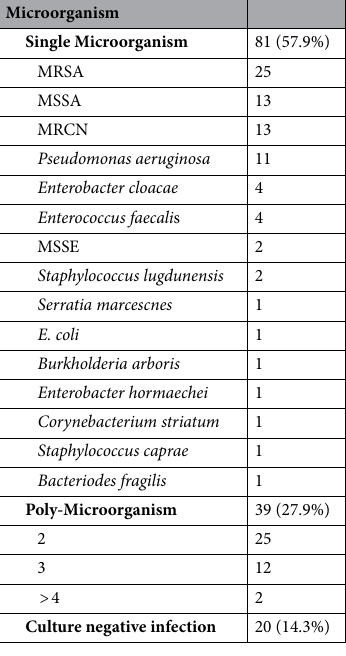
Table 2. Isolated microorganisms. MRSA: methicillin-resistant staphylococcus aureus, MSSA: methicillin- susceptible staphylococcus aureus, MRCN: methicillin- resistant coagulase negative streptococcus epidermidis, MSSE: methicillin-susceptible streptococcus